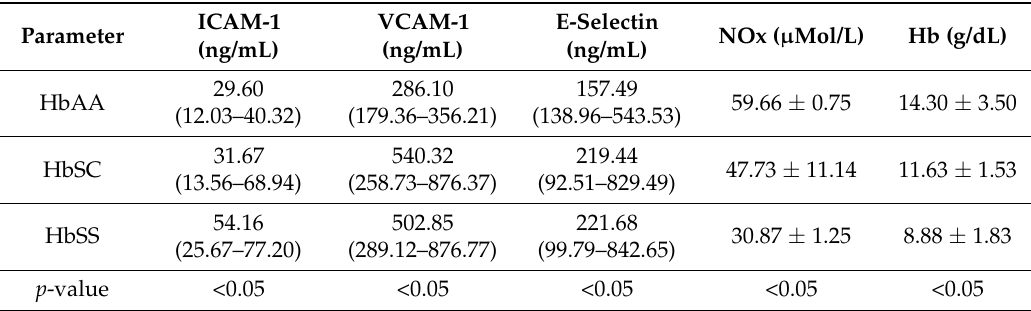
Table 1. Plasma concentrations of circulating adhesion molecules, Nitric Oxide metabolites, and haemoglobin levels in the study participants.